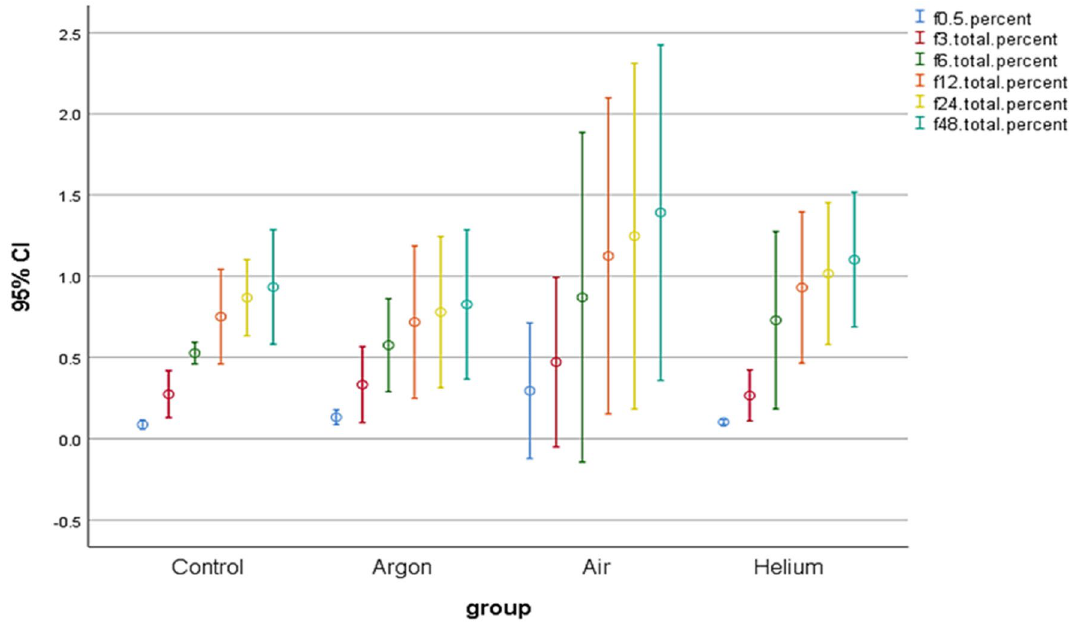
Figure 8. Investigation of the effect of plasma processing on the release of fluoride ions from FV. Ion meters measure the fluoride ions release at 0.5, 3, 6, 12, 24, and 48 h with P ≤